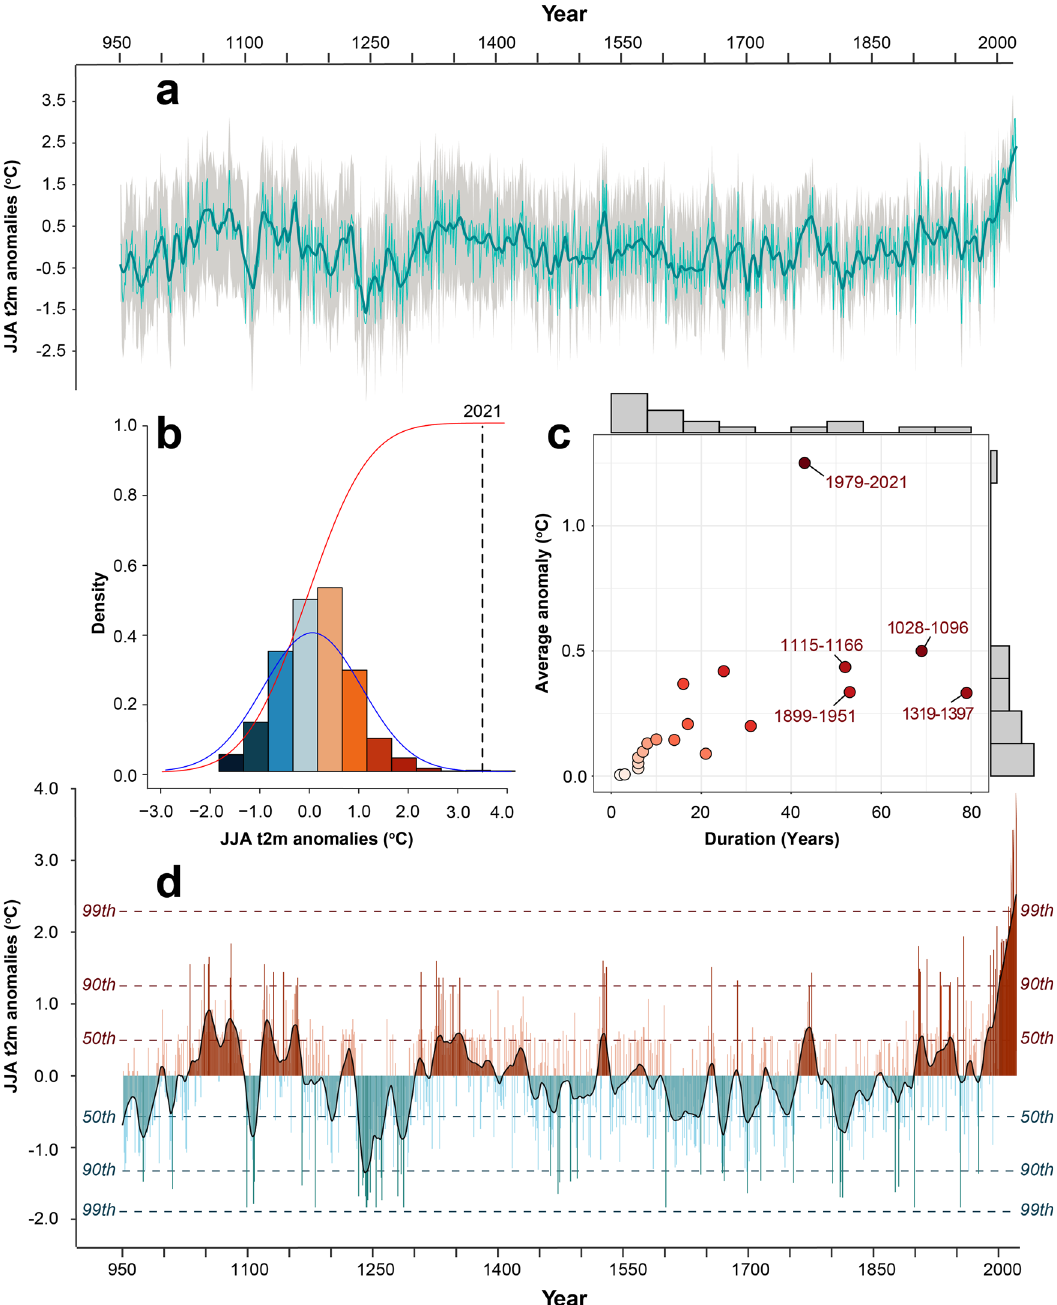
Fig. 2 Long-term estimates of summer temperature variability for the Paci fi c Northwest. Historical estimates of summertime mean temperatures (June-August t2m) over the Paci fi c Northwest from 950 – 2021 CE. a Annual reconstructed temperature anomalies (light teal line) relative to the 1951 – 1980 mean, with 10-year LOESS smoother (dark teal line) and associated error (gray line) of the model back through time. b Distribution of reconstructed temperature anomalies with the density distribution (blue line) and cumulative probability density function (red line) curves. c Bivariate characterization of multi-year warm events corresponding to time series in panel d . d Annual reconstructed temperature anomalies overlaid with 30-year LOESS smoothed time series of multi-year temperature departures, with the 50th, 90th, and 99th percentiles of all warm and cool departures denoted by horizontal dashed lines. Warm departures are colored red, and cold departures are colored blue. Warm and cool departures, which are at or exceed the 90th percentile, are denoted with dark red and blue bars,